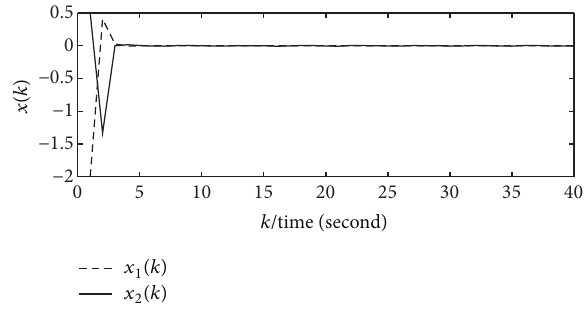
Figure 1: Response curves of system states 𝑥(𝑘) .